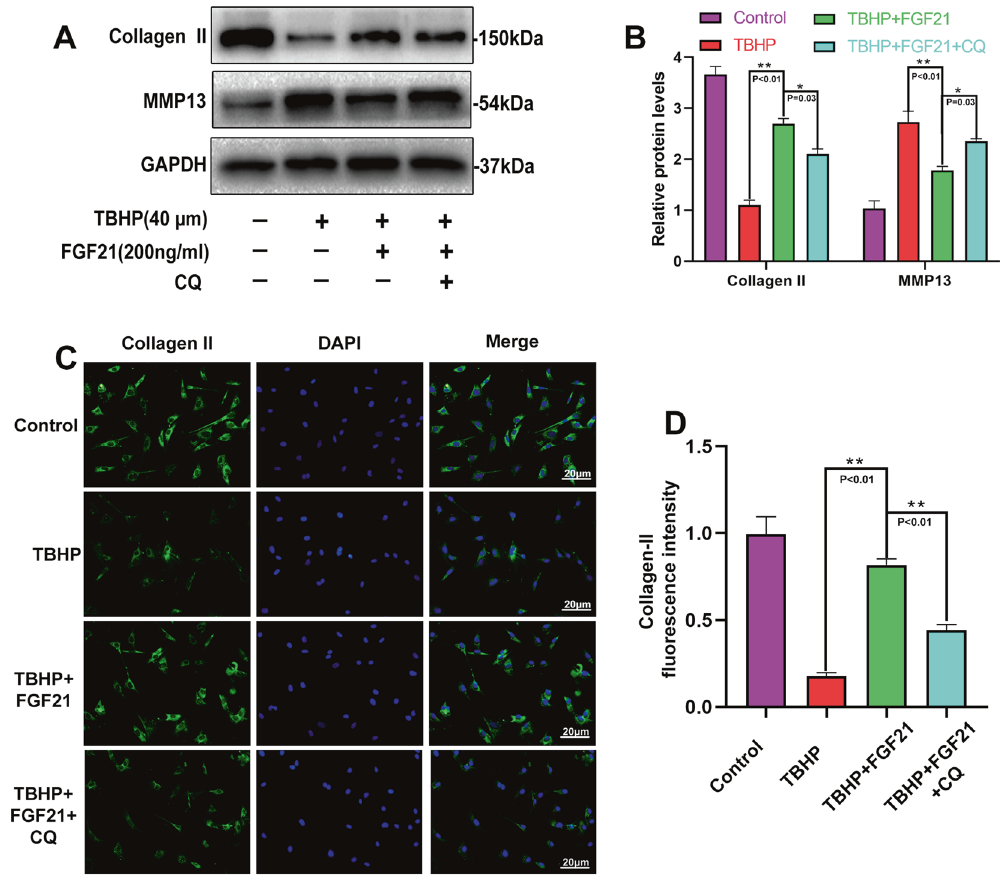
Fig. 5 CQ reversed the effect of FGF21 on the ECM of chondrocytes under oxidative stress. A , B Shown are the changes in the levels of Collagen II and MMP13 in chondrocytes, evaluated using western blot analysis. C , D The representative Collagen II was detected using the immuno fl uorescence analysis combined with DAPI staining for the nuclei (scale bar of Collagen II: 20 μ m; scale bar of MMP13: 20 μ m). The data in the fi gures are the averages ± S.D. Signi fi cant differences between the treatment and control groups are indicated as ** P < 0.01 and * P < 0.05, n =